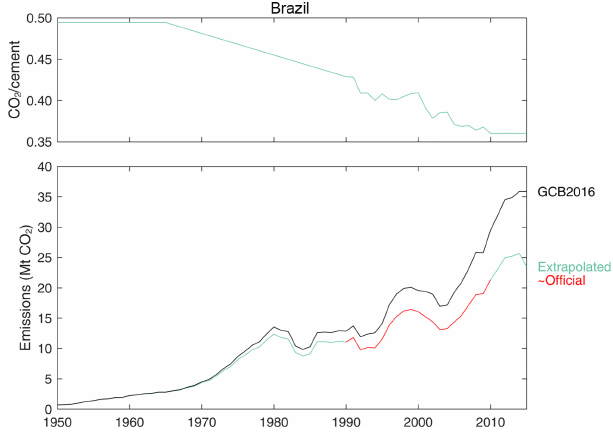
Figure D14. Revised cement emissions for